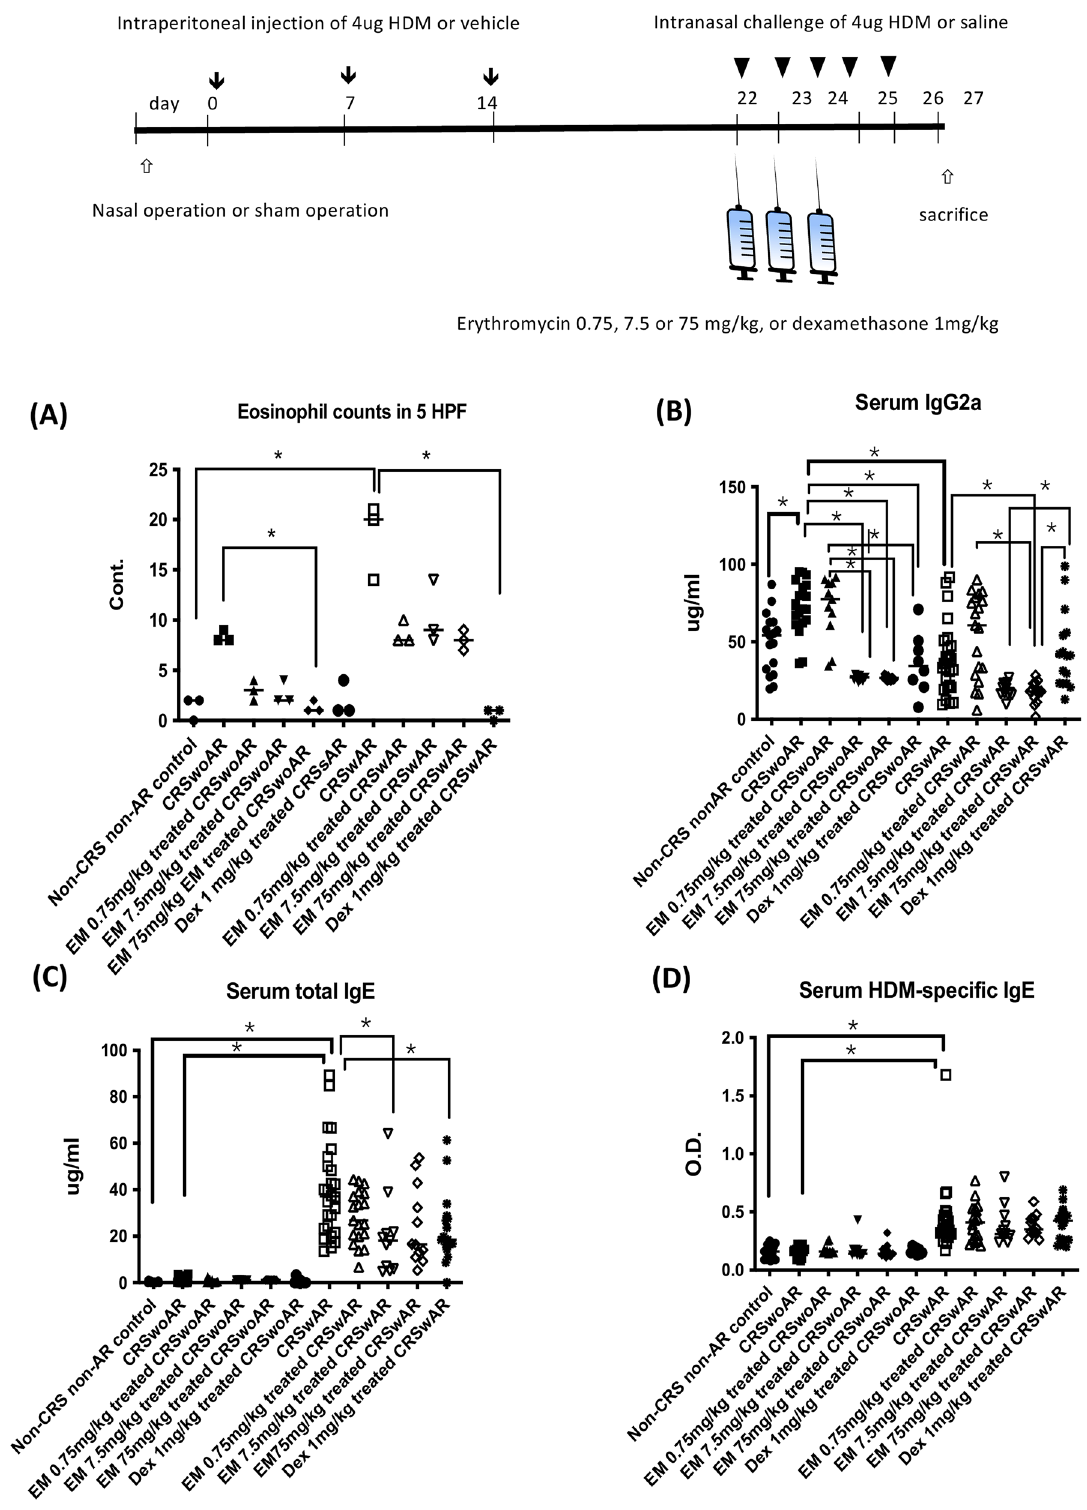
Figure 4. Protocol of mice experiments. ( A ) total eosinophil counts of 5 high power views in lamina propria of nasal mucosa. ( B – D ) IgG2a, IgE, and house dust mite specific IgE levels of experimental mice. CRSwoAR: chronic rhinosinusitis without allergic rhinitis; CRSwAR: chronic rhinosinusitis with allergic rhinitis; EM: erythromycin; Dex: dexamethasone. Horizontal line represents medium of each group. *P <